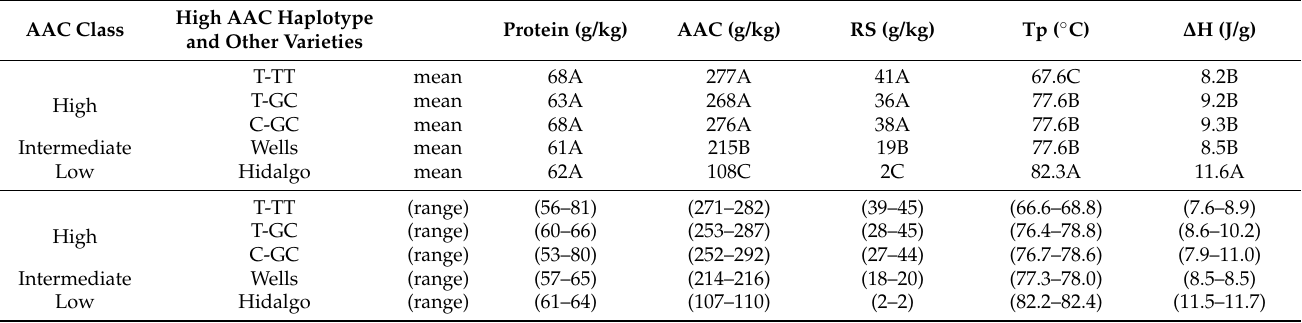
Table 2. Protein, AAC, RS content, and thermal properties of all rice varieties †